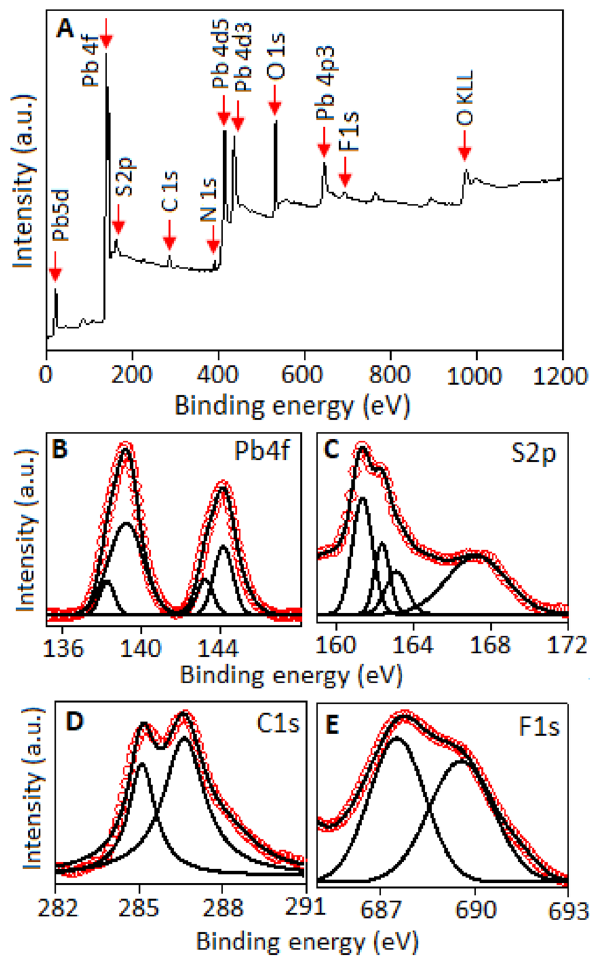
Figure 4. ( A ) The XPS survey spectrum of fluoroaniline stabilized lead sulfide. High-resolution XPS spectrum of ( B ) Pb 4f, ( C ) S 2p, ( D ) C1s and ( E )